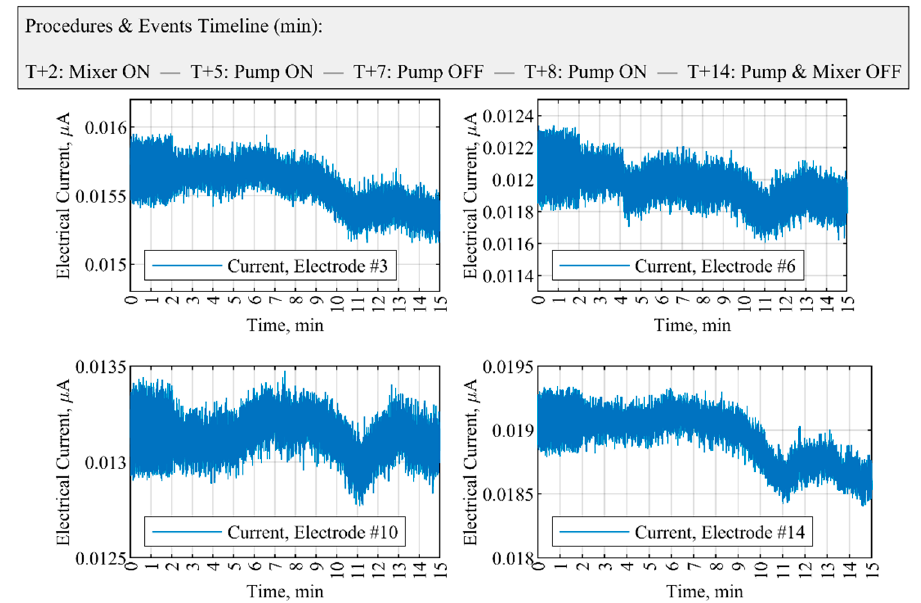
Figure 11. Performance of different sensors during feed pump failure situations (case no. 2 in Table 3). Sensors are separated at 90-deg apart inside the crystallizer. The initial CaCl 2 concentration is 1.6 g L − 1 . The feed flow rate is 40 mL min − 1 , and mixing speed is 100 RPM. Table 5. Comparison of the slope of electrical current over all the electrodes of the ERT system. The slope factor, K , is calculated at the time that the pump is switched off, which triggers an alert based on electrode no. 2. The data illustrate the malfunction scenarios for case no. 2 in Table 3 and Figures 10 and 11. t 1 = 6.3–7.1